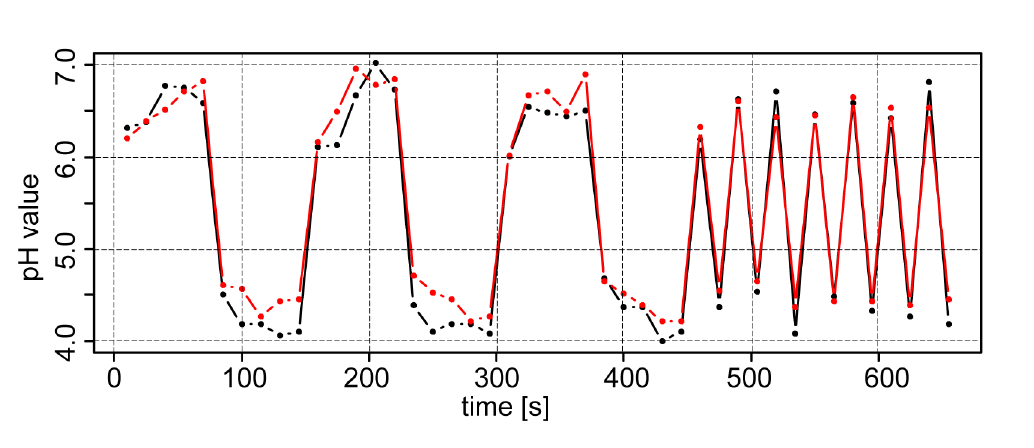
Figure 5. Consecutive measurements with the pH antimony electrode 1 (black) and 2 (red) in two soil samples with different pH values under laboratory